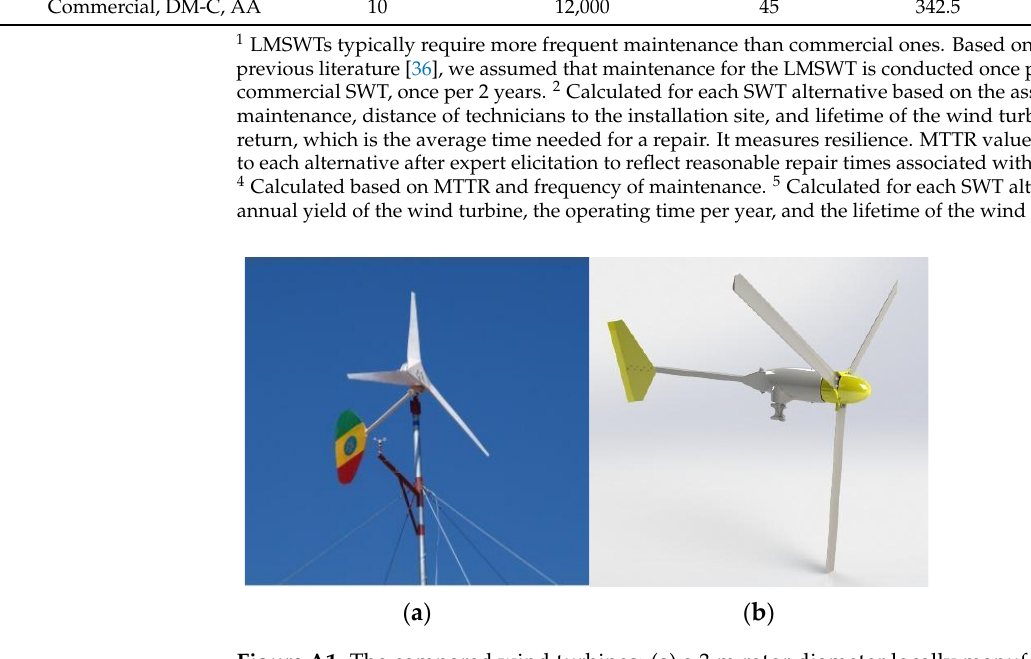
Figure A1. The compared wind turbines: ( a ) a 3 m rotor diameter locally manufactured small wind turbine (source: rurerg.net, accessed on 24 May 2022); ( b ) a Bergey XL.1 (source: bergey.com, accessed on 3 July 2020).